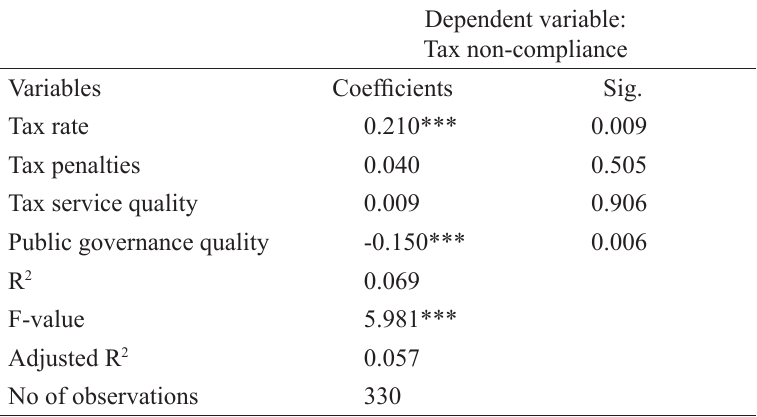
Multiple Regression